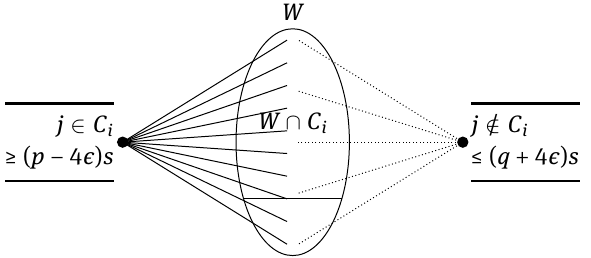
Figure 4: If W has large overlap with C i , then a.s. vertices in C i will have many neighbors in W , while vertices not in C i will have relatively few neighbors in W